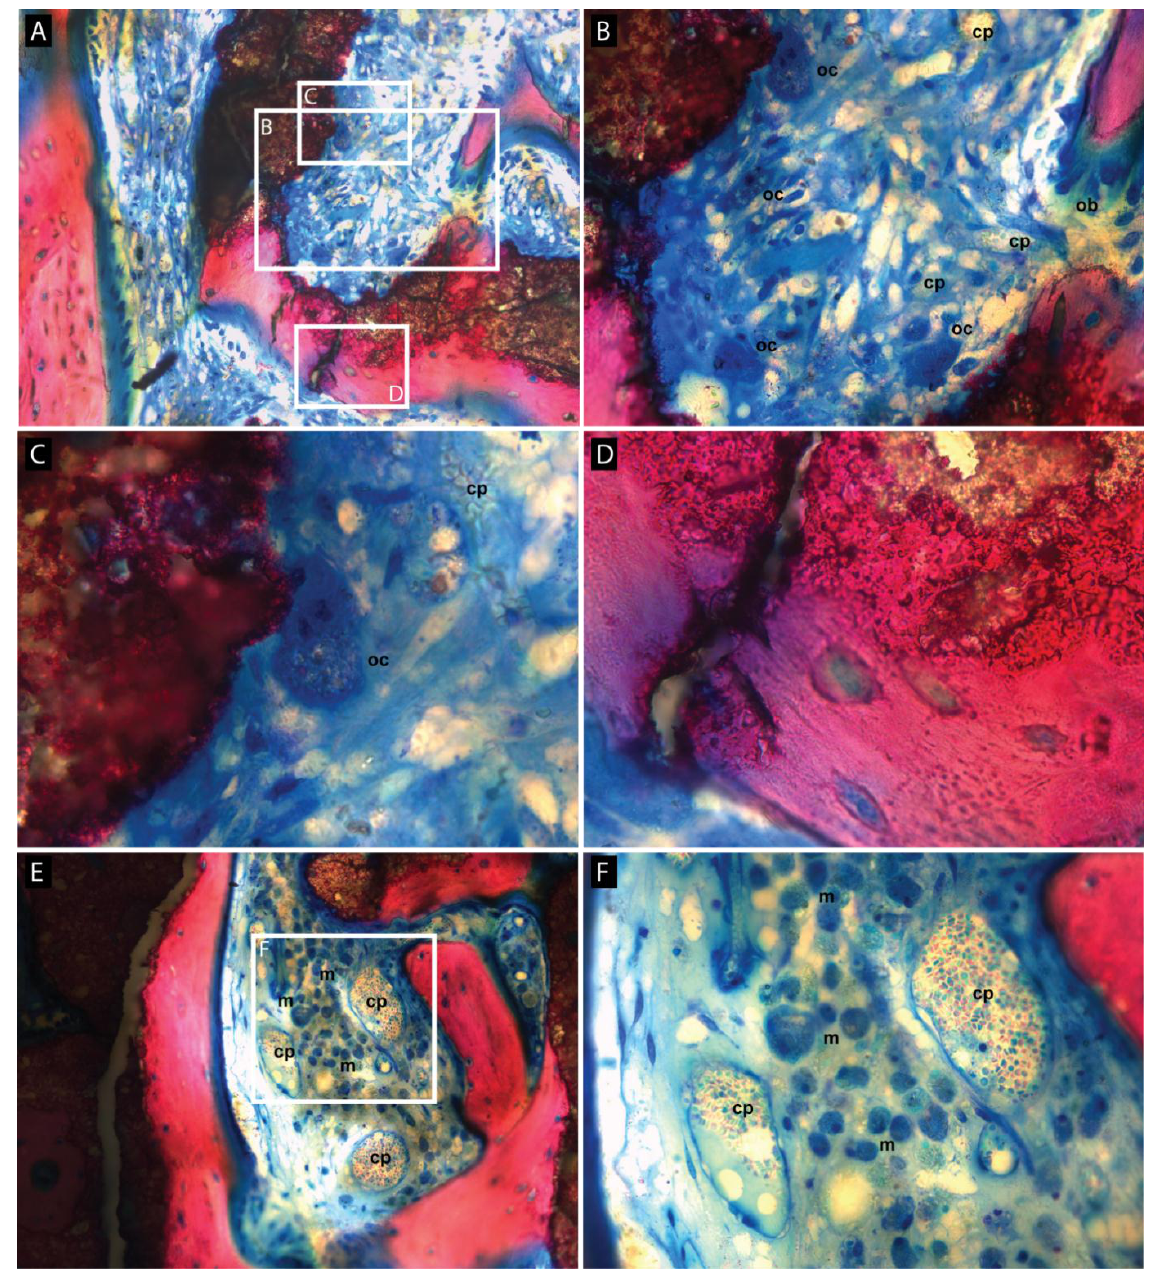
Figure 3. Higher magnifications of active zones of resorption in a BMP-2 primed construct ( A , E ) showing various processes of resorption of the scaffold at 8 weeks. The fibroid and osteoid tissue (blue) is highly vascularized ( B , C , F ), as shown by the broad presence of capillaries (cp), and is rich in plump macrophages (m) harboring intracytoplasmic debris; some osteoclasts (oc) are present and active ( B , C ). The bone substitute is not only degraded via cellular activity, but is also biochemically dissolved into the newly synthesized bone ( D